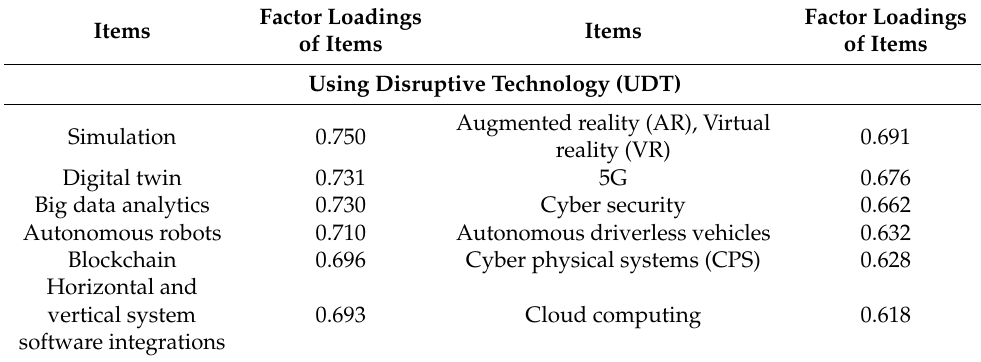
Table 10. Factor Loadings for EFA Model